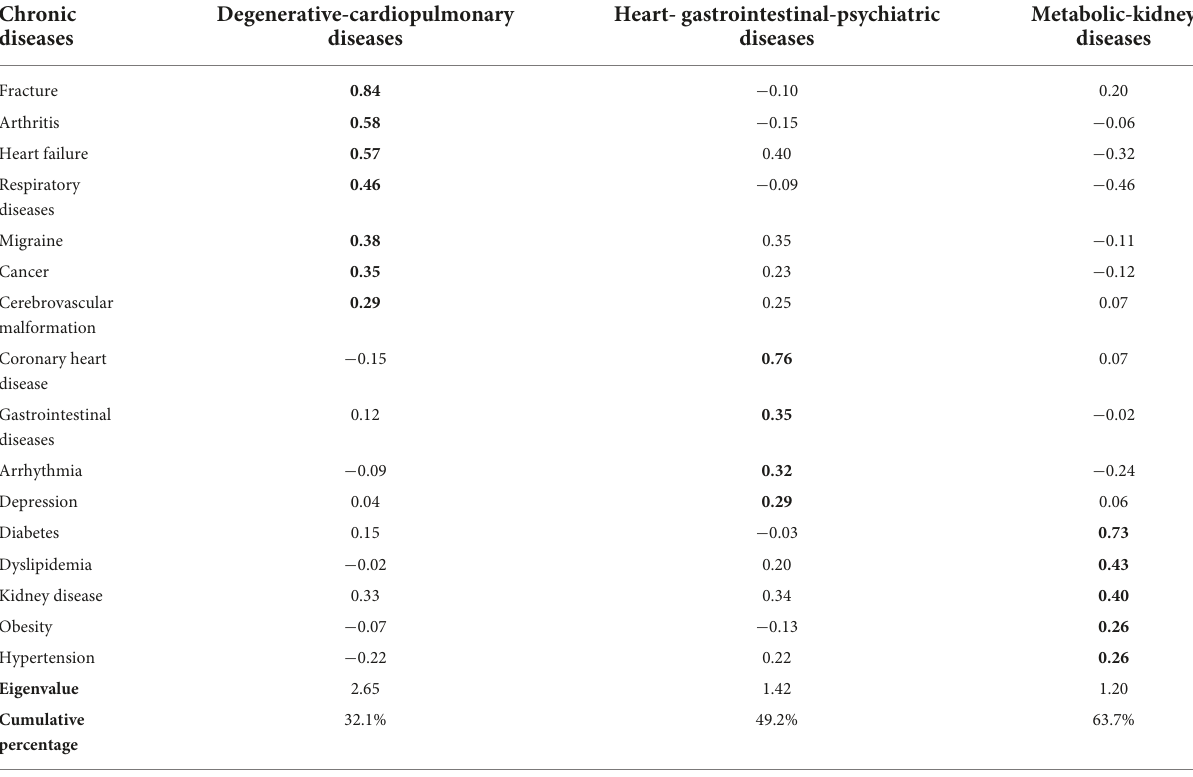
TABLE 2 Rotated loadings for each of the 16 chronic disease categories by three groups from factor analysis.